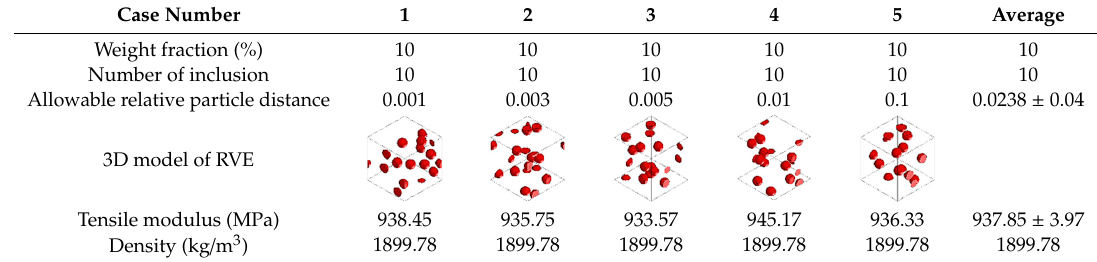
Table 2. Variation of mechanical properties obtained by micromechanical analysis for different particle configurations.